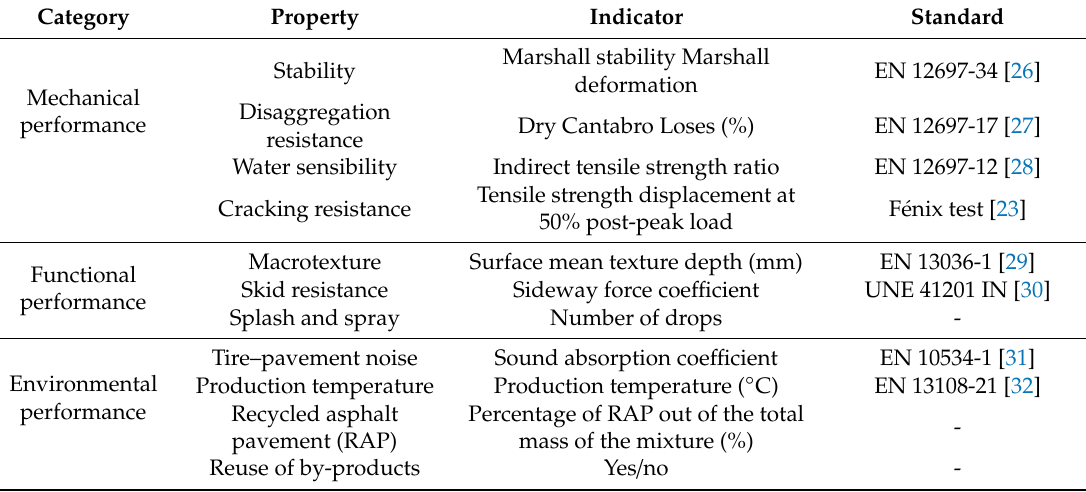
Table 1. List of considered properties for each category.